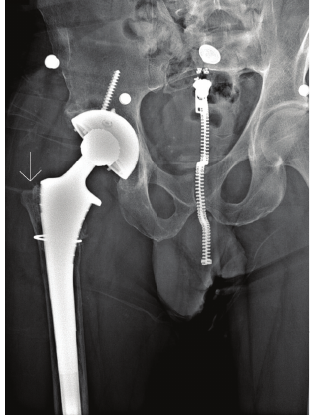
Figure 2: Status post reduction. Note GT bone loss